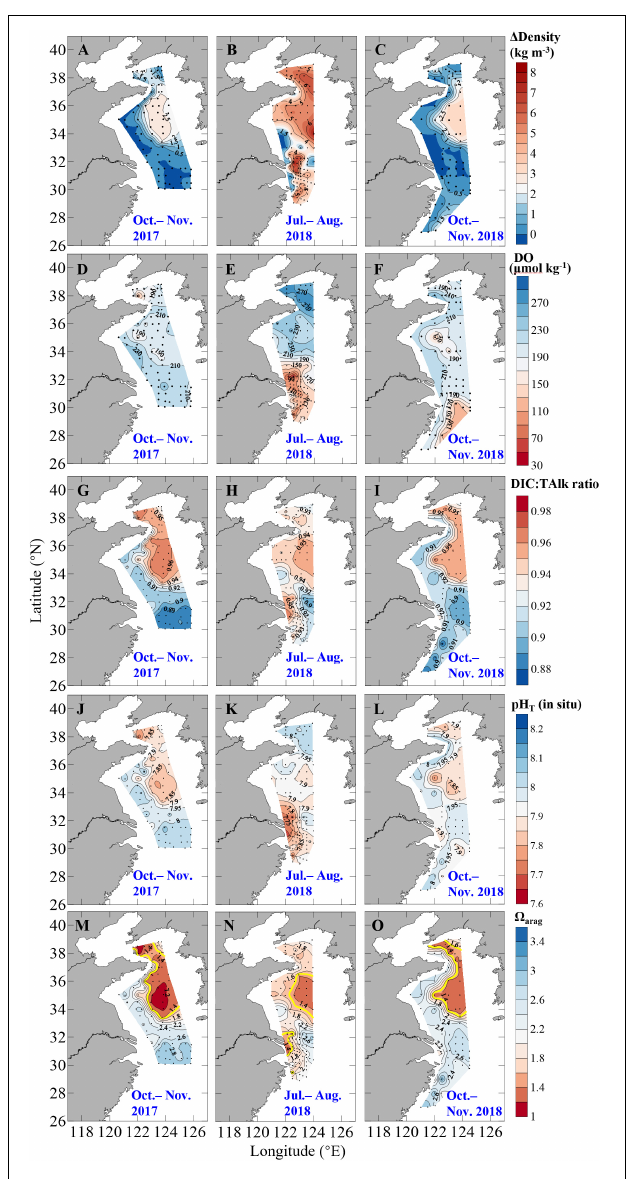
FIGURE 3 | Distributions of (A–C) density difference between bottom and surface waters ( (cid:49) Density), bottom-water (D–F) dissolved oxygen (DO), (G–I) DIC:TAlk ratio, (J–L) pH T ( in situ ), and (M–O) aragonite saturation state ( (cid:127) arag ) in autumn 2017, summer 2018 and autumn 2018. In panels (M–O) , contours of bottom-water critical (cid:127) arag level of 1.5 are plotted as thick yellow